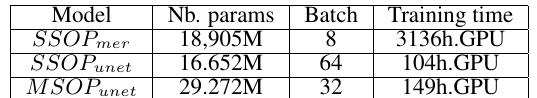
Table 2. Number of parameters in the trained models, batch size used, and training time (in hours.GPUs) for the training step on a NVIDIA V100 GPU with 32Gb RAM. The training time corresponds to the duration required to computed the best model.